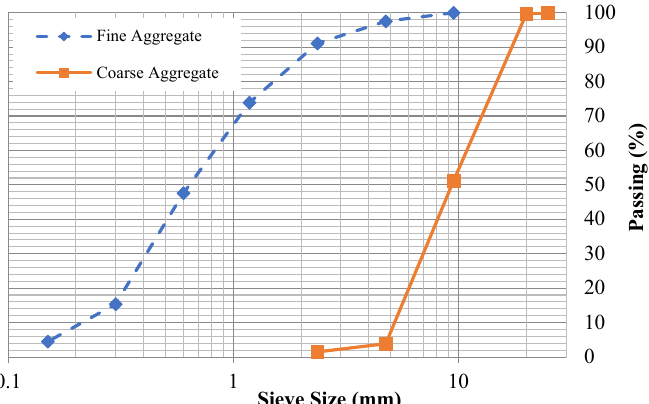
Figure 1. Particle size distribution of aggregates.